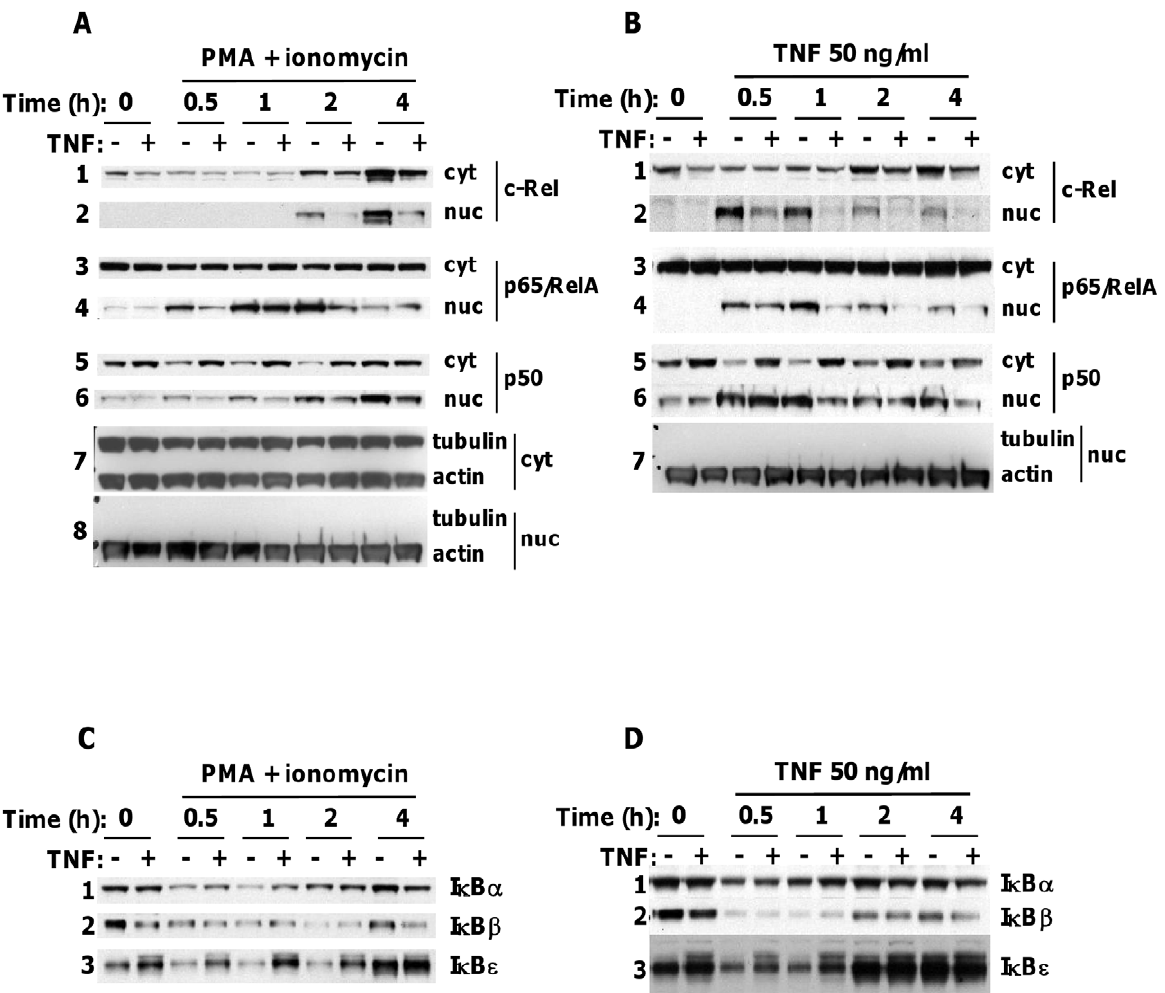
Figure 2. TNF pre-treatment inhibits subsequent induction and nuclear expression of NF- k B and upregulates I k B e . 11A2 cells were cultured with or without TNF 2.5 ng/ml for 8 days before restimulation with PMA 10 ng/ml and ionomycin 50 ng/ml or TNF 50 ng/ml for the time- points indicated. Nuclear and cytoplasmic extracts were prepared and equivalent amounts of protein assayed for the presence of NF- k B transcription factors (A, B) and I k B isoforms (C, D) by immunoblot. Each blot represents at least three similar experiments, probed then reprobed for the indicated proteins.